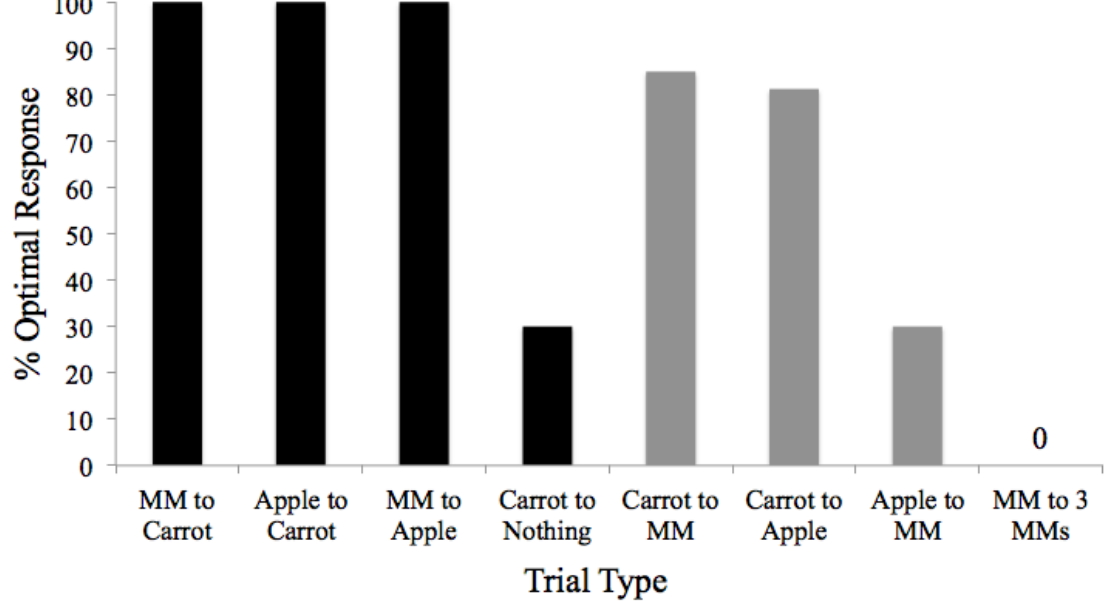
Figure 2 . Training performance for the food exchange self-control task in Experiment 1. Black bars depict Quality Decreasing trials (optimal response was to eat the first higher-valued food item rather than exchanging it for the second lower-valued food item). Gray bars depict Quality Increasing trials (optimal response was to exchange the first lower-valued food item for the second higher-valued food item). Note that MM represents one